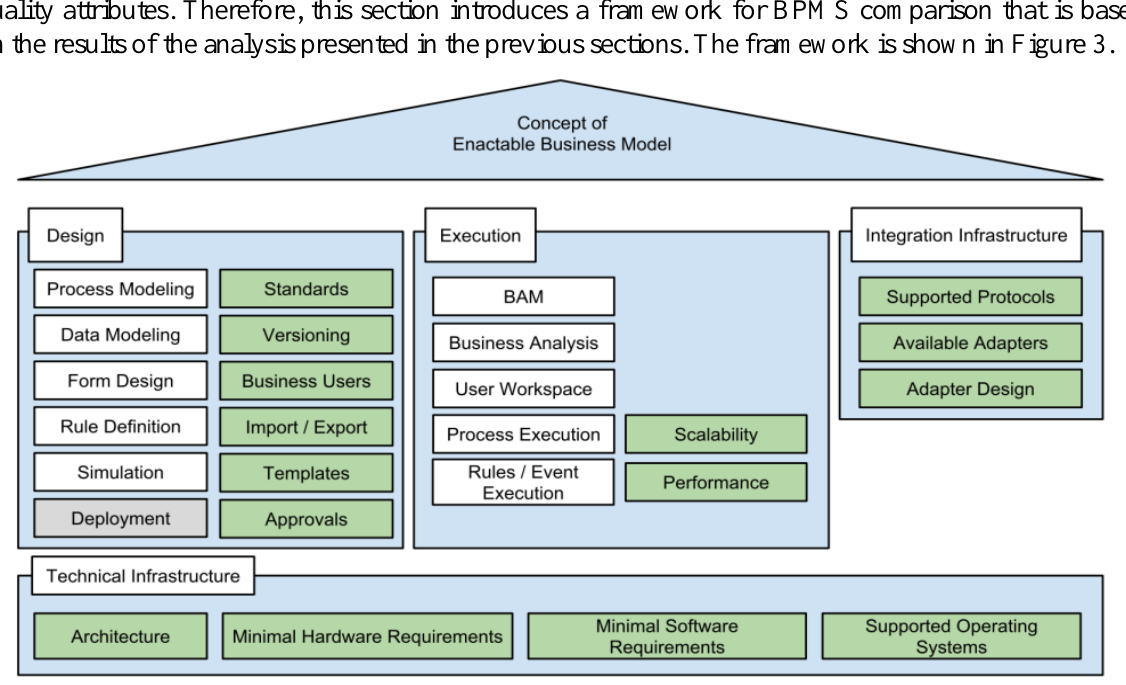
Figure 3. Proposed framework for BPMS comparison (available also in